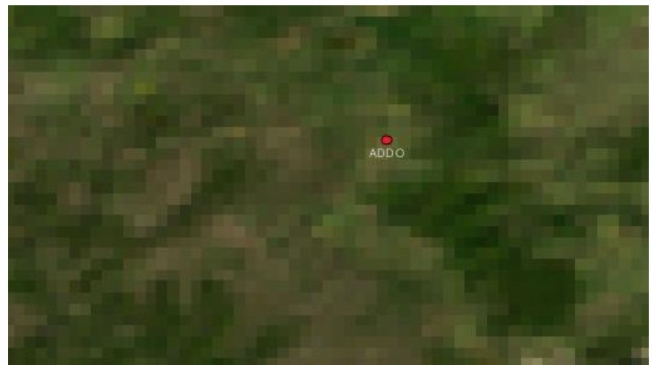
Figure 5. Resolution of a raster image.